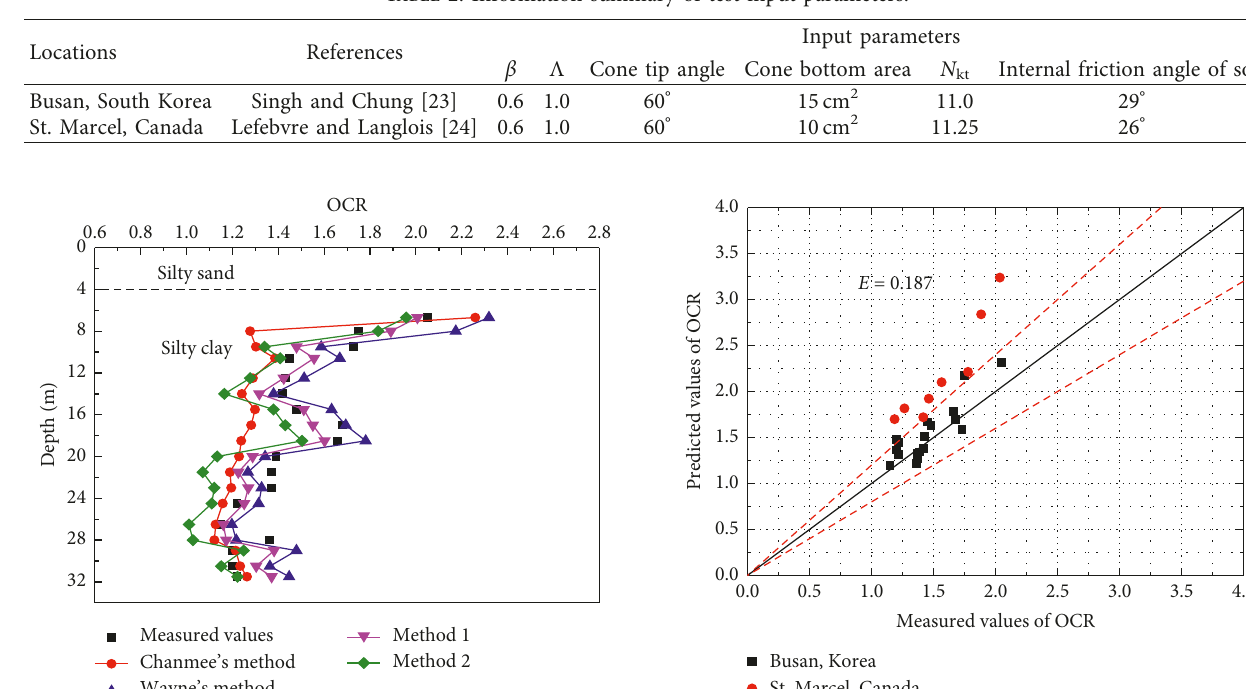
Table 2: Information summary of test input parameters.